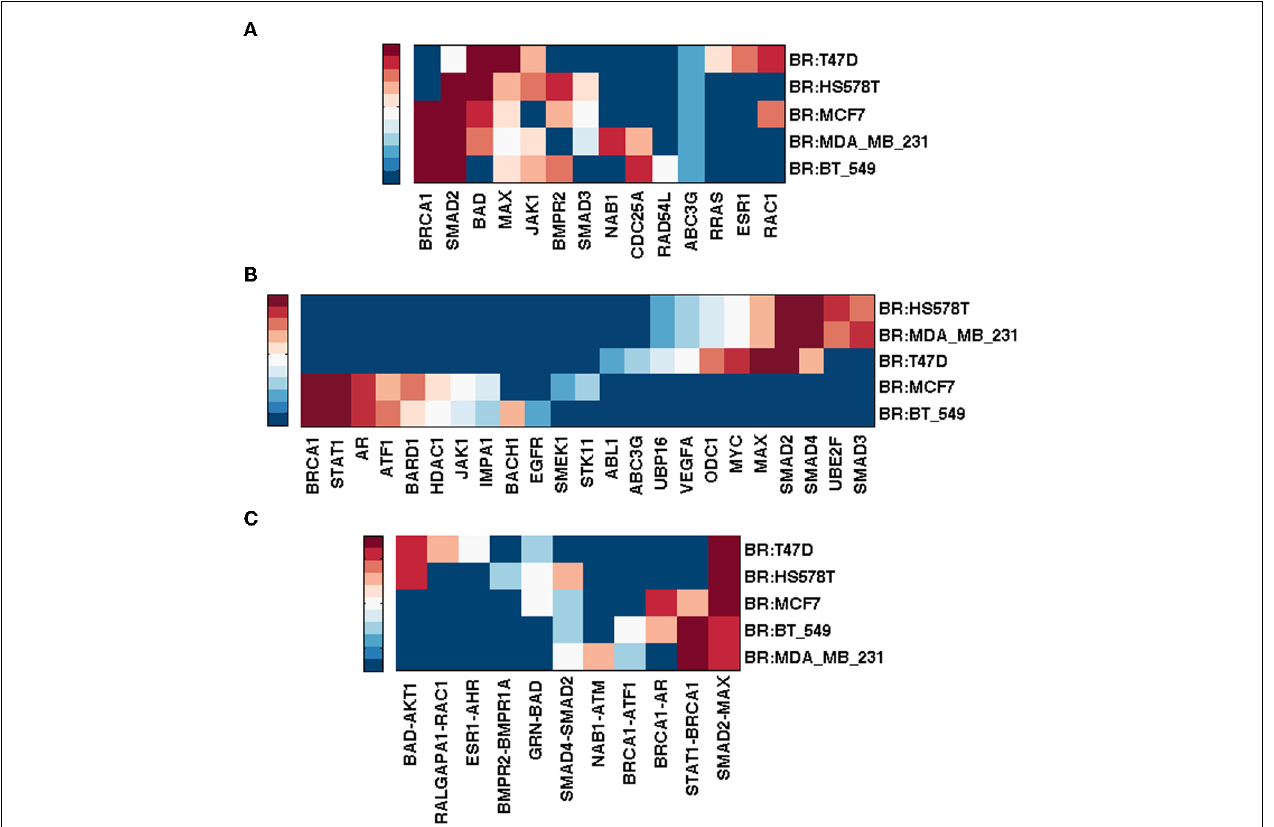
FIGURE 5 | Top ranked nodes and edges of integrated breast cancer pathway conditioned on NCI60 breast cancer cell lines. Ranks range from 1 (dark red) to 10 (blue), and > 10 (the darkest blue) for (A,B) ; from 1 (dark